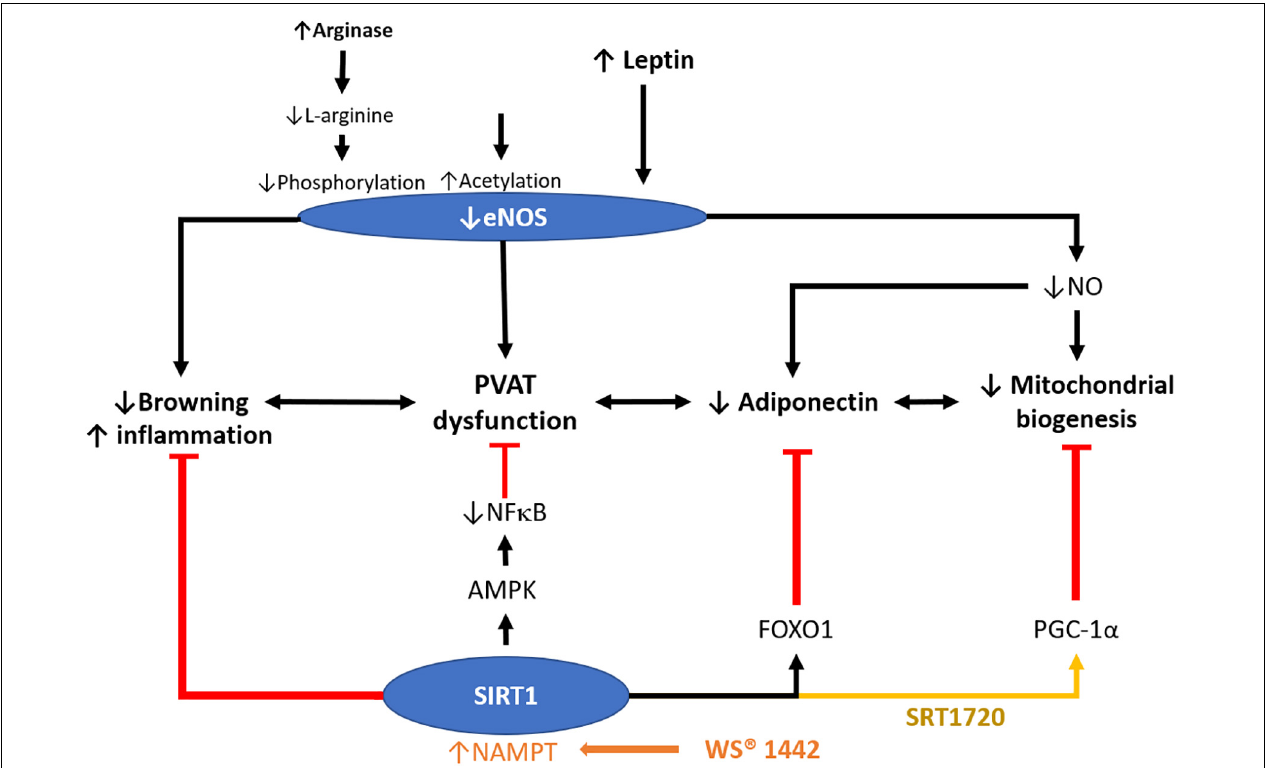
FIGURE 3 | Role of SIRT1 in modulating PVAT function. PVAT is critical in modulating vascular function. Crataegus extract WS R (cid:13) 1442 activates SIRT1 via increased NAD + production by NAMPT. WS R (cid:13) 1442 prevents PVAT dysfunction via reversing the reduced phosphorylation and enhanced acetylation of PVAT eNOS caused by HFD feeding. SIRT1 ameliorates PVAT dysfunction caused by NF κ B activation and PVAT inflammation fructose (Chen et al., 2016) or HFD (Sun et al., 2014). SIRT1 also increases mitochondrial biogenesis via PGC-1 α . NO, nitric oxide. HFD, high-fat diet. PGC-1 α , peroxisome proliferator-activated receptor-gamma and coactivator-1 alpha. NF- κ B, nuclear factor kappa-light-chain-enhancer of activated B cells. NAMPT, nicotinamide phosphoribosyltransferase. AMPK, 5 (cid:48) AMP-activated protein kinase.